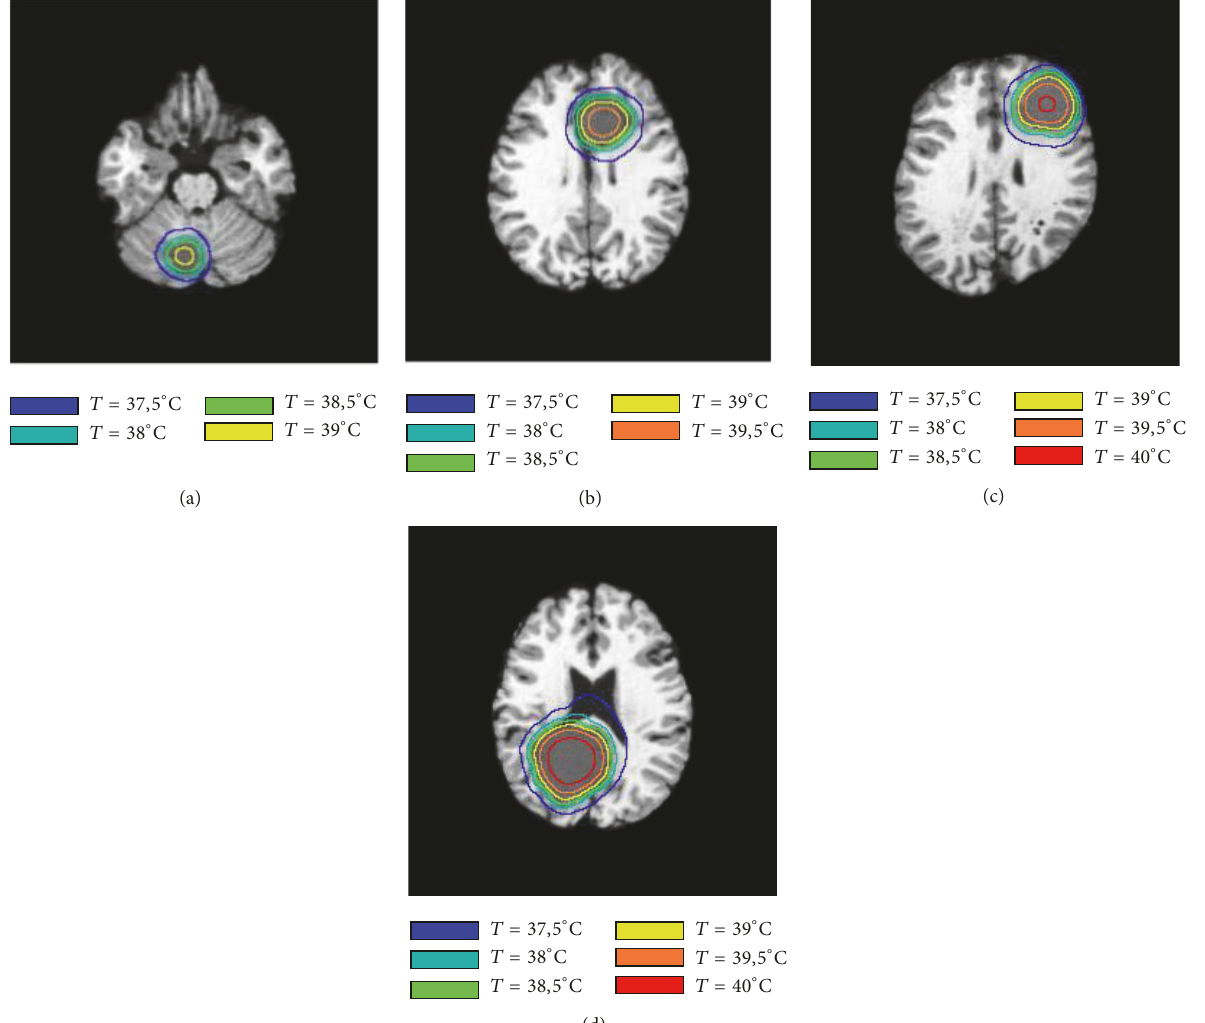
Figure 5: Temperature isotherms in the four cases to show the degree of variation of temperature in the tumorous